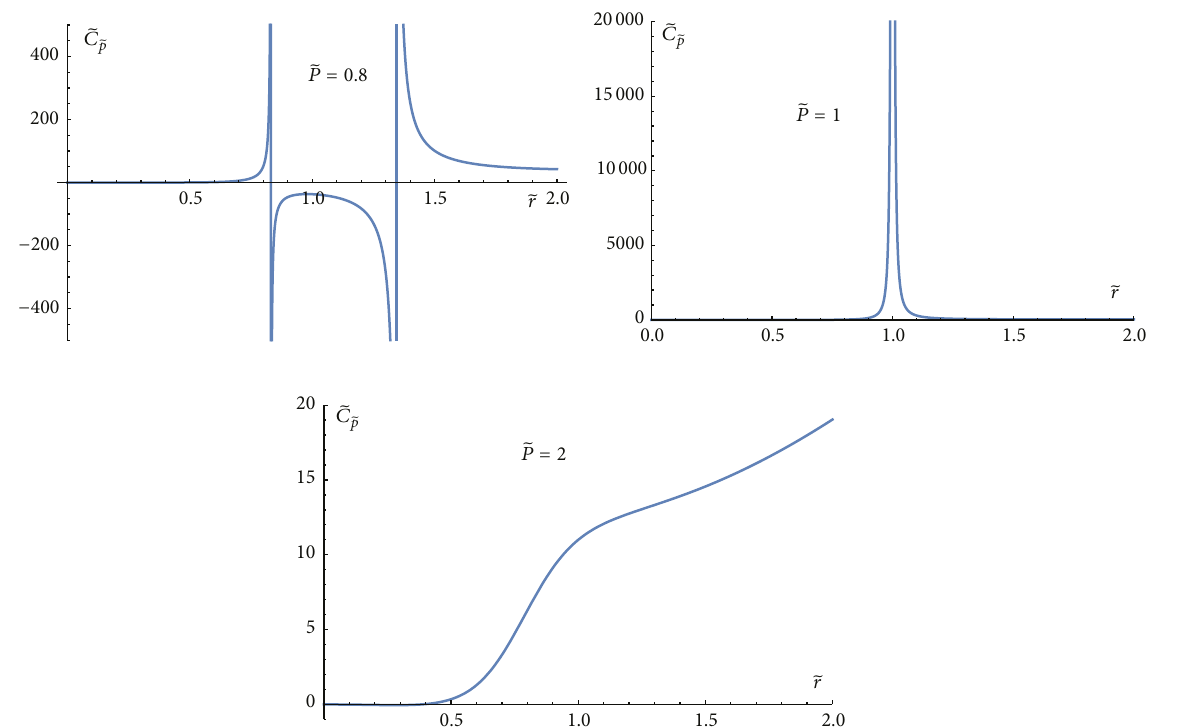
̃𝐶 ̃𝑟 for ̃𝑃 = 0.8 < ̃𝑃 Figure 1: The specific heat ̃𝑃 vs. 𝑐 which has two divergent points, ̃𝑃 = 2 > ̃𝑃 𝑐 which has no divergent point.